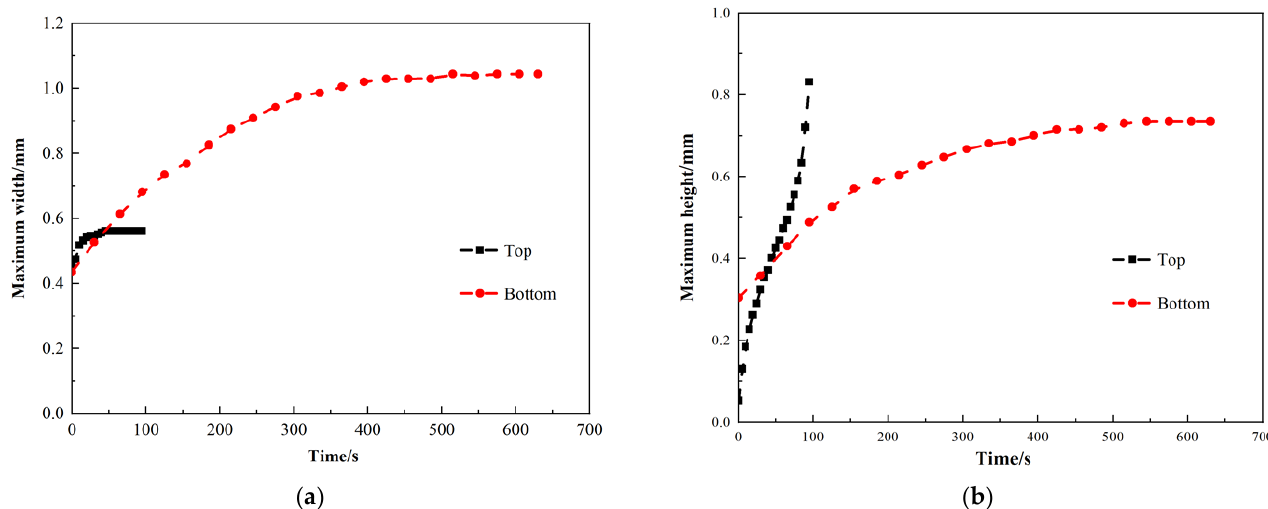
Figure 8. Change of oil drop size in different discharge direction. ( a ) Comparison of maximum width of oil drop; ( b ) Comparison of maximum height of oil drop.